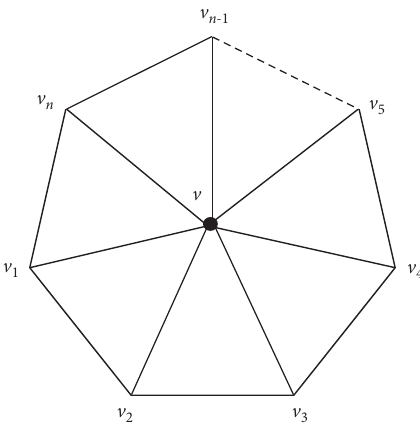
Figure 3: Wheel graph W